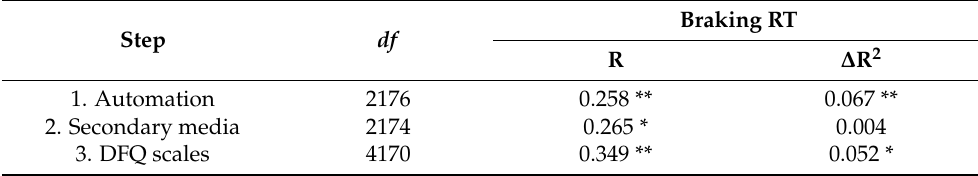
Table 7. Summary statistics for regression of braking RT on experimental factors and DFQ scales.